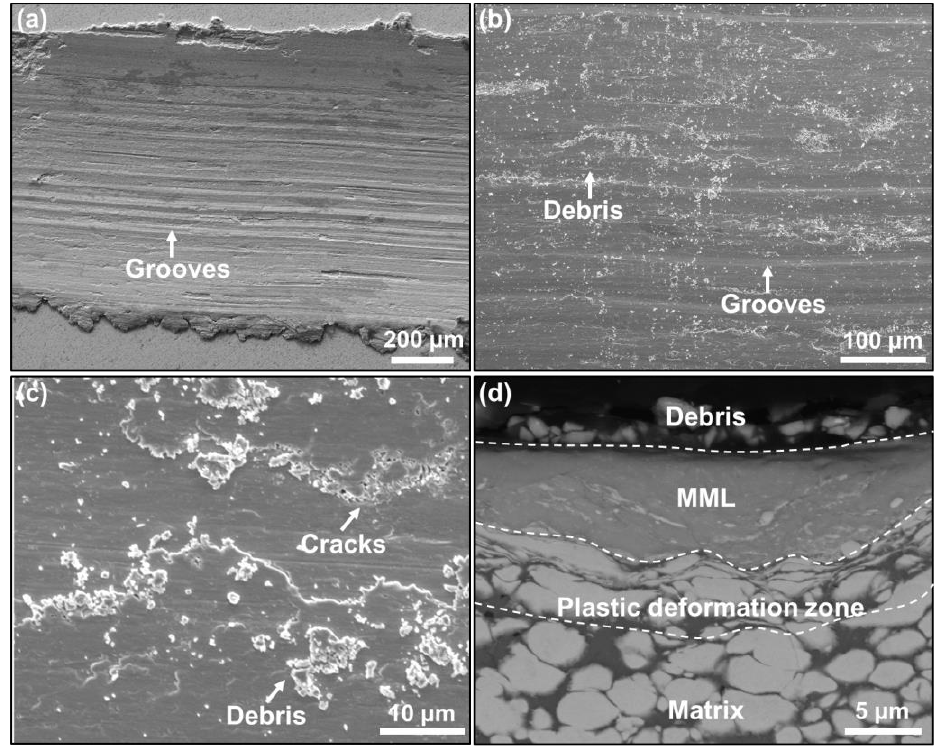
Figure 4. SEM images of worn surfaces ( a – c ) and cross-sectional microstructure under the wear scar ( d ) of the CCG W–Cu composite.